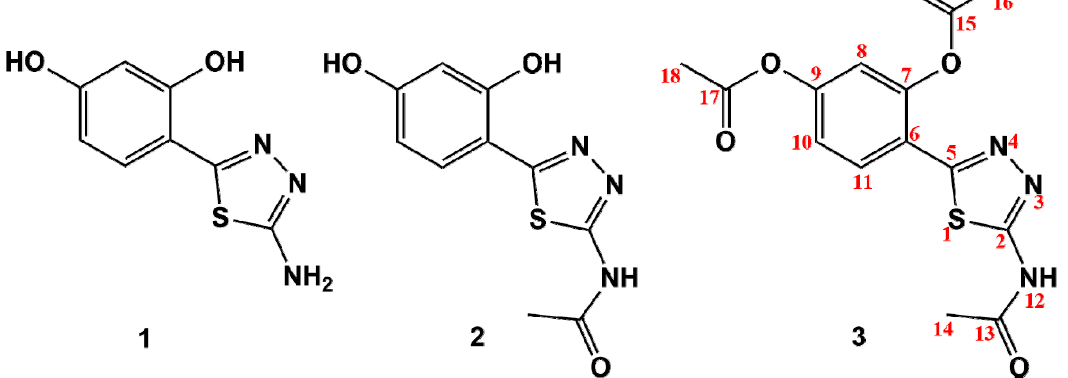
Figure 1. Structures of the 1,3,4-thiadiazole-derived ligands 1 , 2 , 3 , and the numbering system of atoms (red) used for the assignment of the 1 H and 13 C NMR chemical shifts.